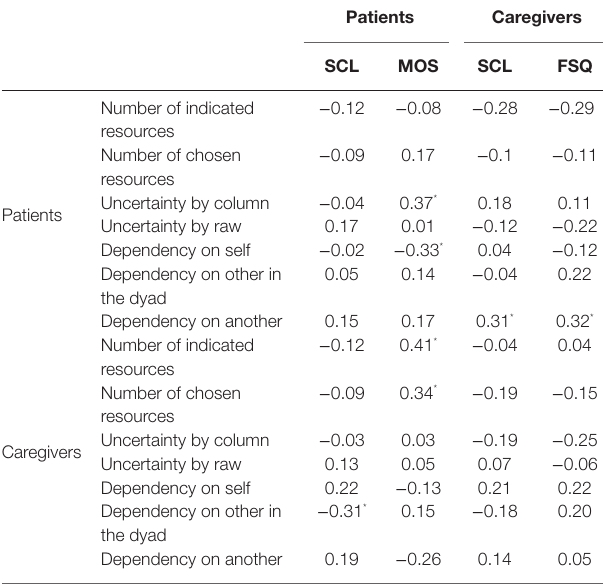
TABLE 2 | Correlations of dependency measures with patients’ and caregivers’ psychological symptoms (SCL), patients’ perceived social support (MOS),